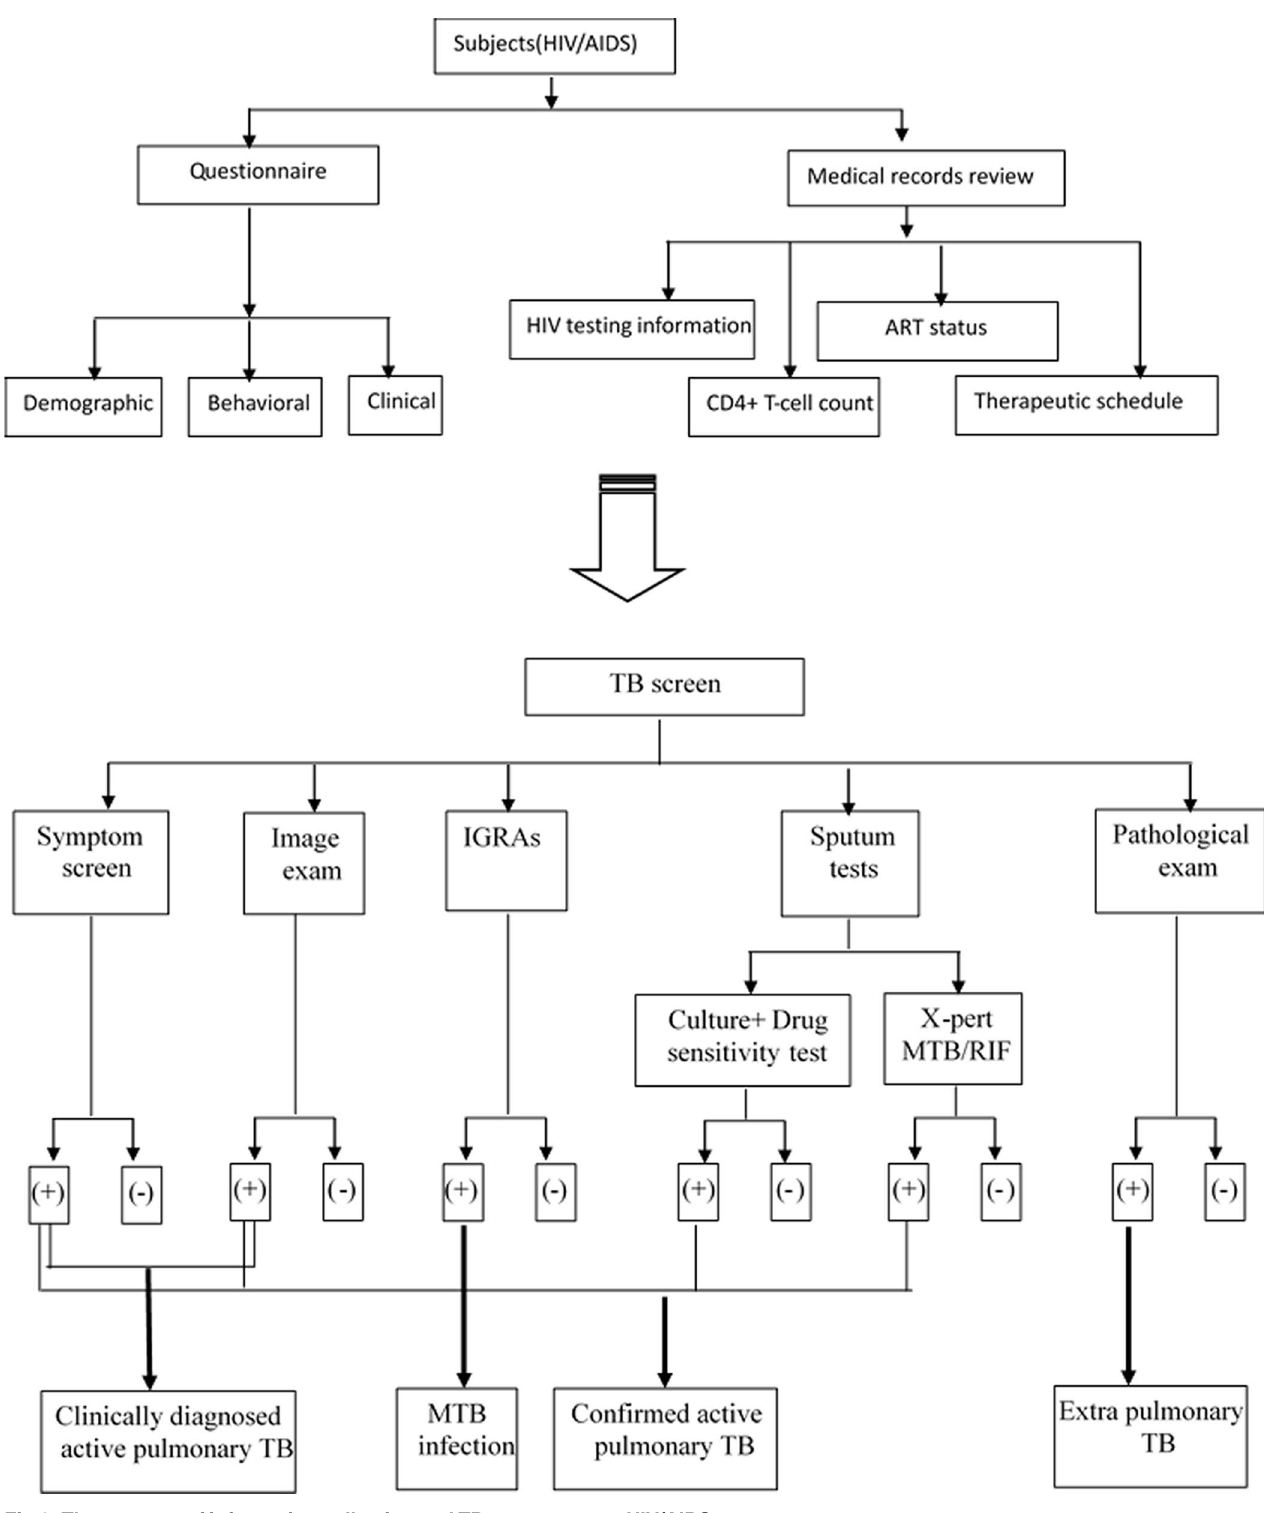
Fig 1. The program of information collection and TB screen among HIV/AIDS.